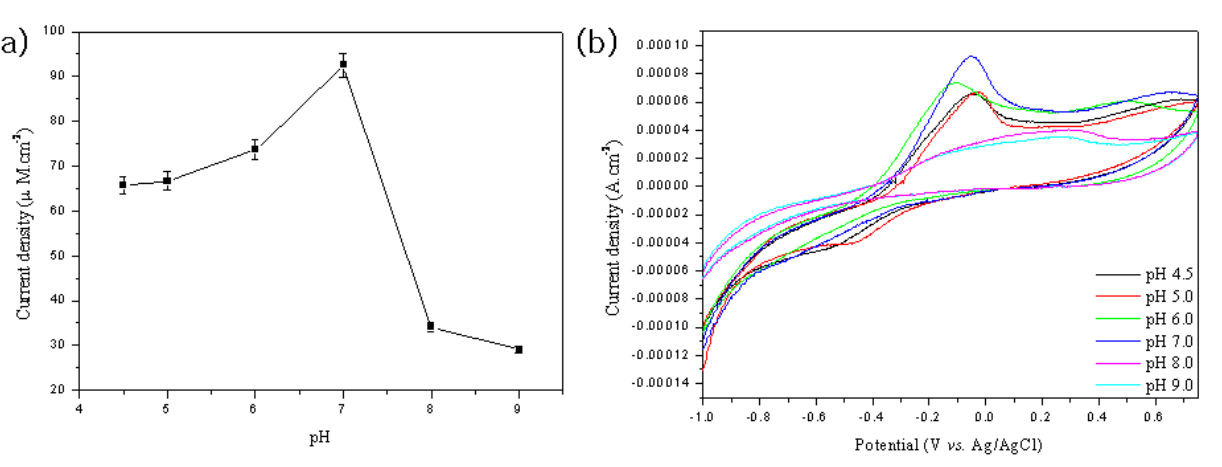
Figure 8. Response sensitivity of the MWNT ion liquid electrode based on tyrosinase as function of pH value for 0.04 mM phenol in 2 mL phosphate buffer (a), (b).